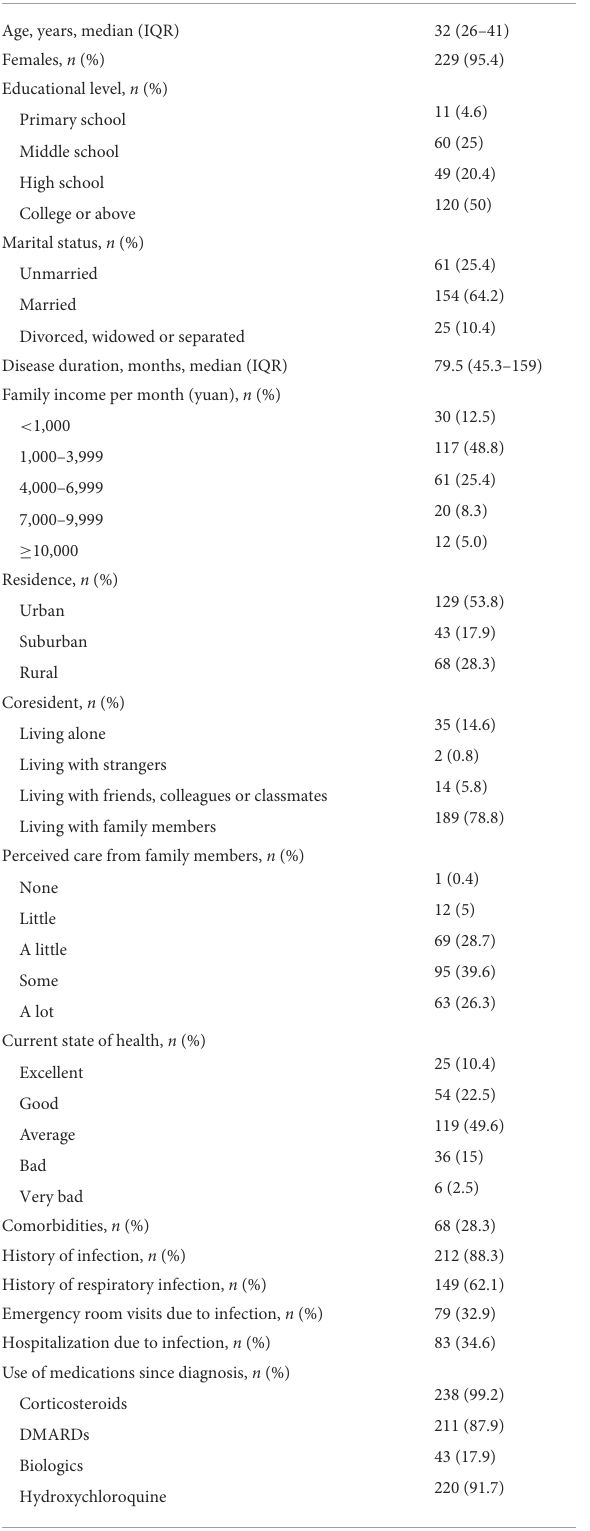
TABLE 1 Characteristics of the